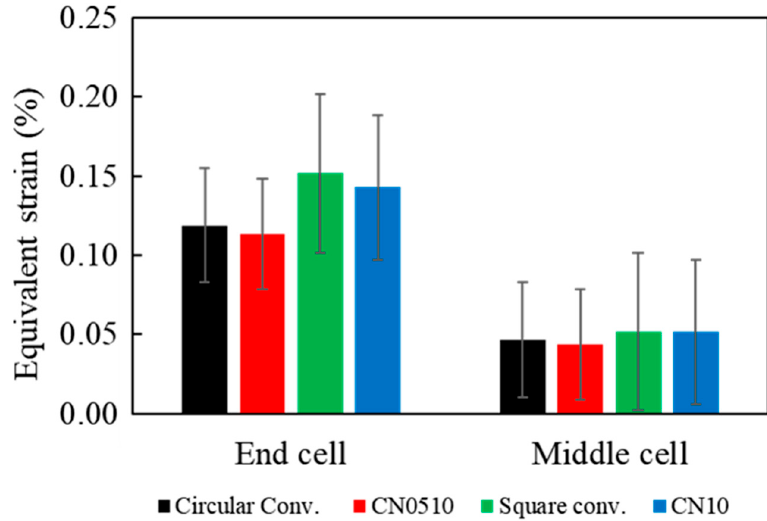
Figure 7. Strain deviation of middle and end cells of the stacks for conventional circular (black), CN0510 (red), conventional square (green), and CN10 (blue) end plates.